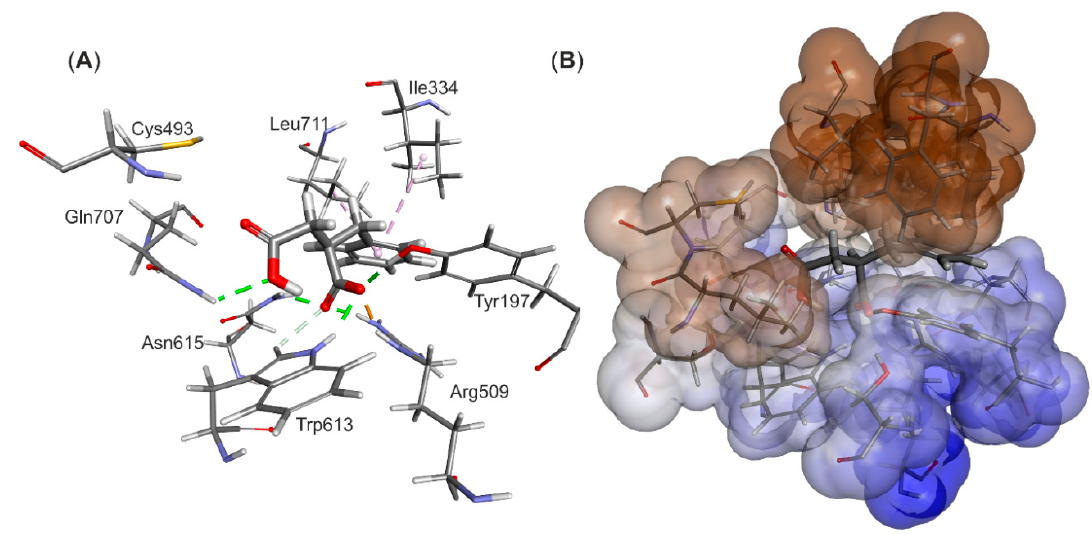
Figure 4. Structural model of the enzyme-product complex. ( A ) Binding mode of the ( R )-benzylsuccinate (monoprotonated) and ( B ) EP complex depicting surface hydrophobicities of the active site residues (blue—hydrophilic, brown—hydrophobic). Interactions are shown by dashed lines in green (H-bond), orange (electrostatic interactions) and violet (vdW interactions).